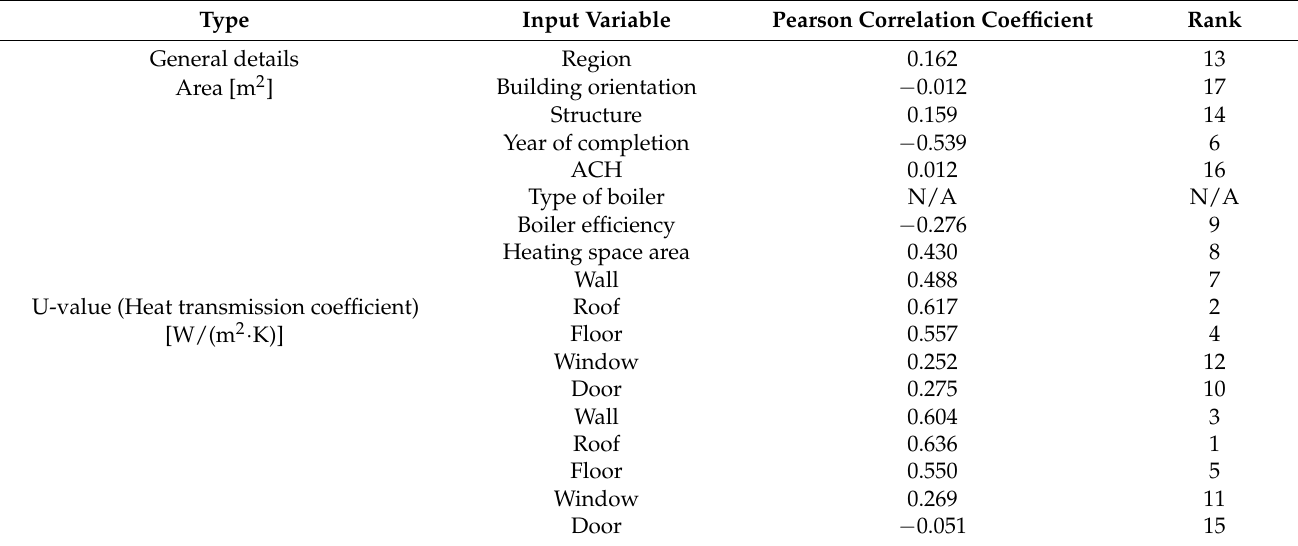
Table 4. Results of Pearson correlation analysis using IBM SPSS Statistics